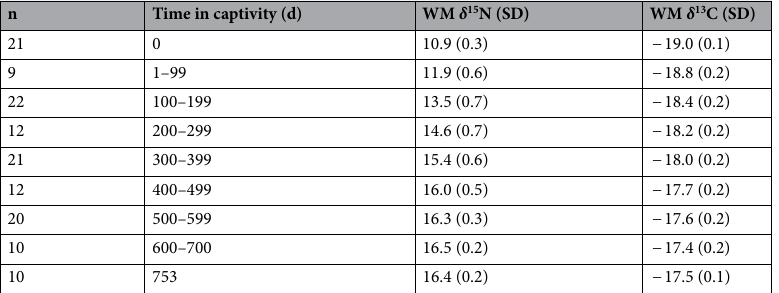
Table 2. Mean stable isotope values and time in captivity for all California yellowtail ( Seriola dorsalis ) used in this study. δ 13 C values are arithmetically-corrected for lipid content based on tissue-specific (fish muscle) algorithms from Logan et al 55 . Note not all fish could be sampled at every sampling period, resulting in varying sample size (n) across the experimental period.